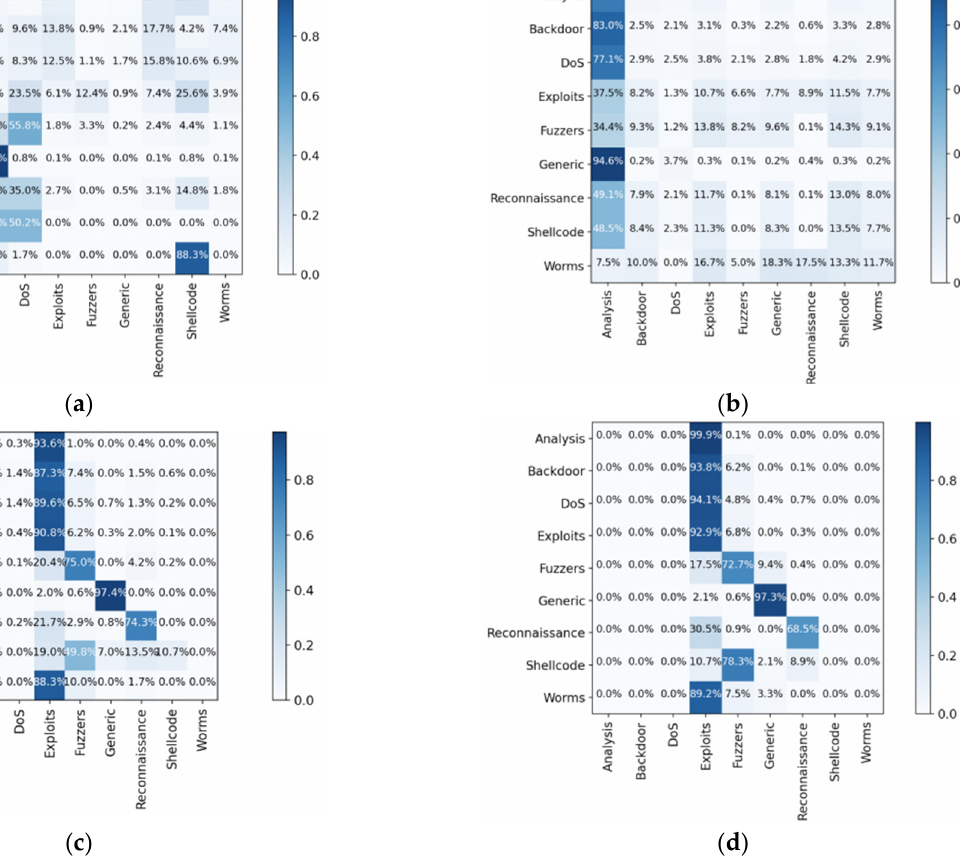
Figure 9. The confusion matrix by four different algorithms. ( a ) K-Means algorithm. ( b ) Mini Batch K-Means algorithm. ( c ) LSTM algorithm. ( d ) UMAP-RF algorithm.